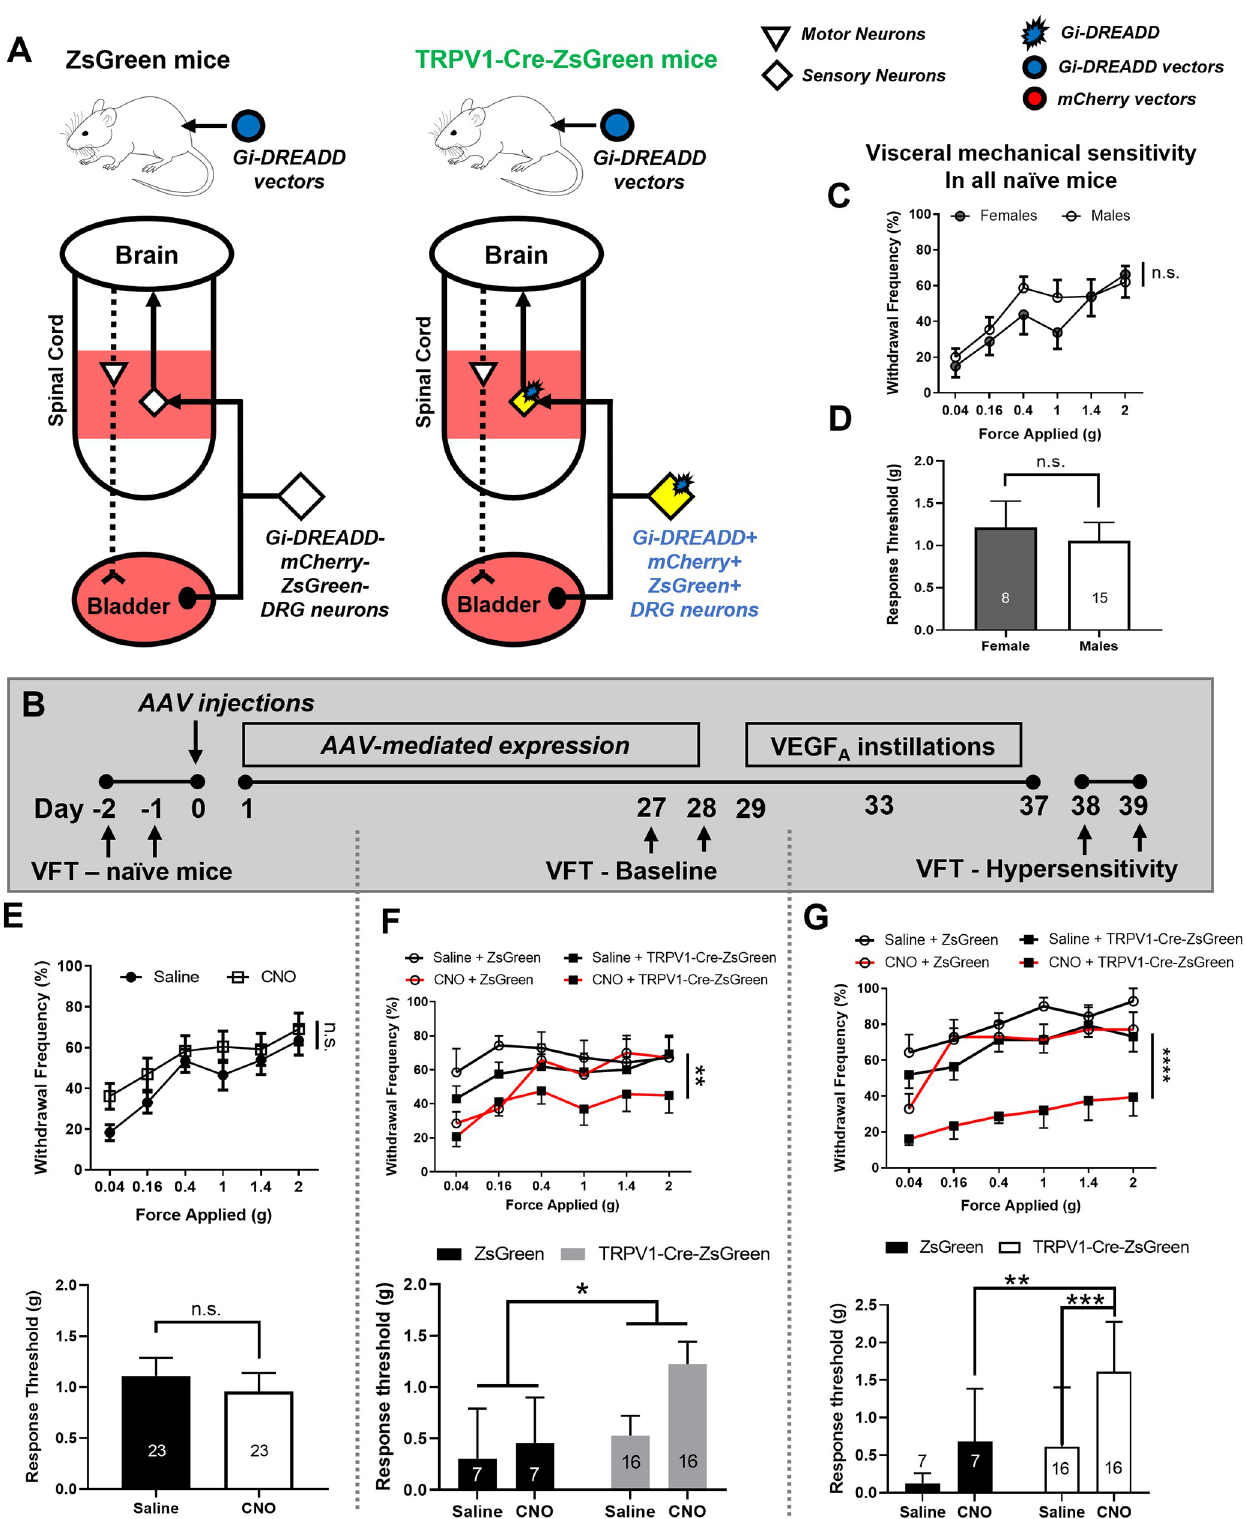
Fig 7. Pharmacogenetic inhibition of lumbosacral sensory neurons alleviated VEGF-induced visceral hypersensitivity in vivo. (A). AAV vectors containing Gi-DREADD were injected into TRPV1-Cre-ZsGreen mice and ZsGreen mice. (B). Experimental timeline: visceral mechanical sensitivity was